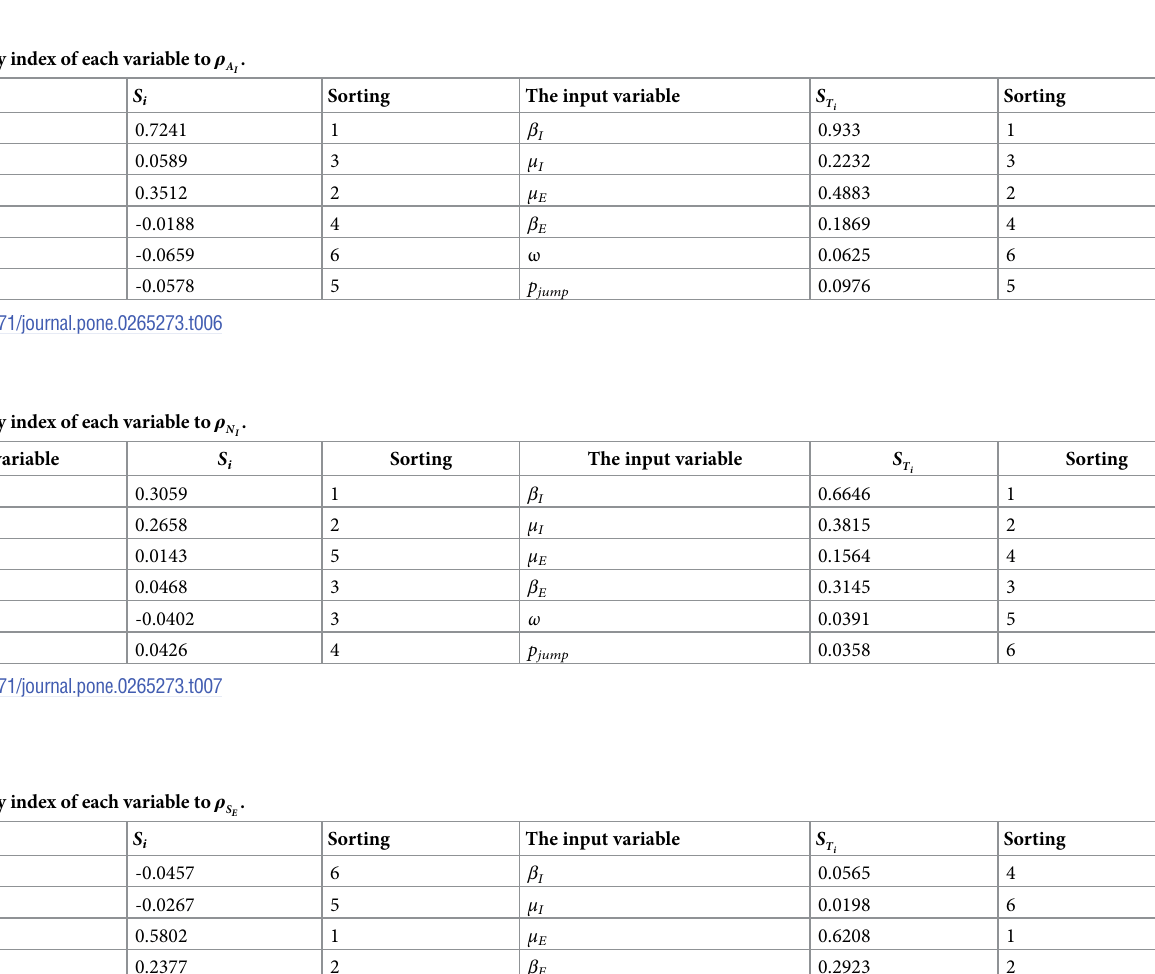
Table 6. Sensitivity index of each variable to ρ